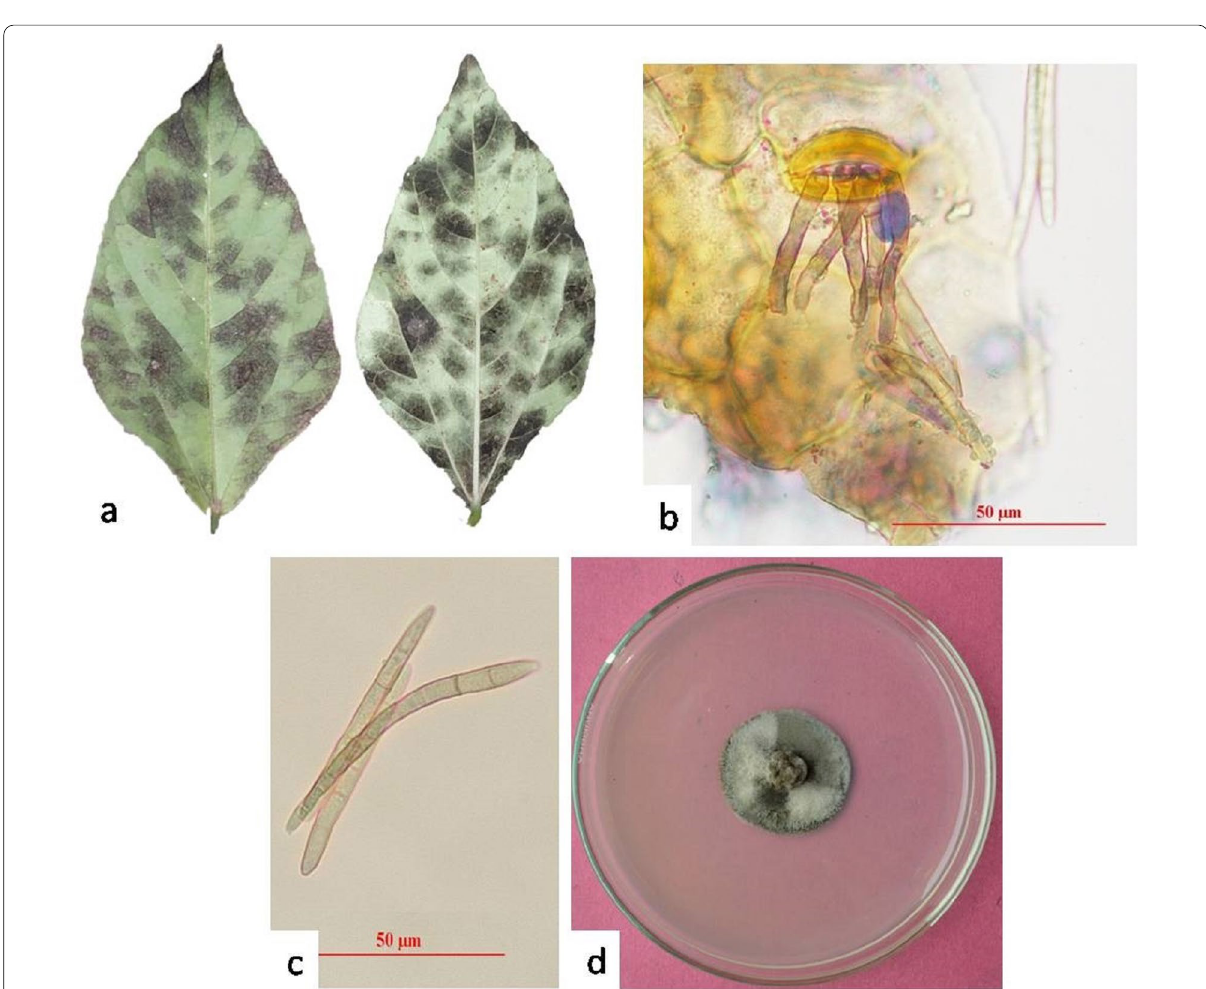
Fig. 9 Pseudocercospora cruenta (isolate Pscow-1; MCC 9095) on Vigna unguiculata a-d, a Symptoms on adaxial and abaxial surface of leaf, b Conidiophore, c Conidia, d Colony on Potato Dextrose Agar (PDA) medium. Bars b and c